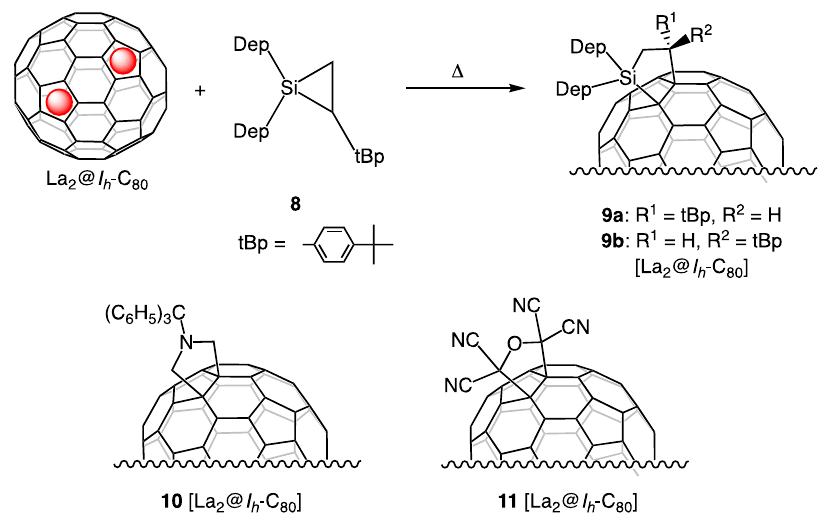
Scheme 4. Synthesis of silirane adducts of La 2 @ I h -C 80 . Partial structures are shown for 9a , 9b , 10 and 11